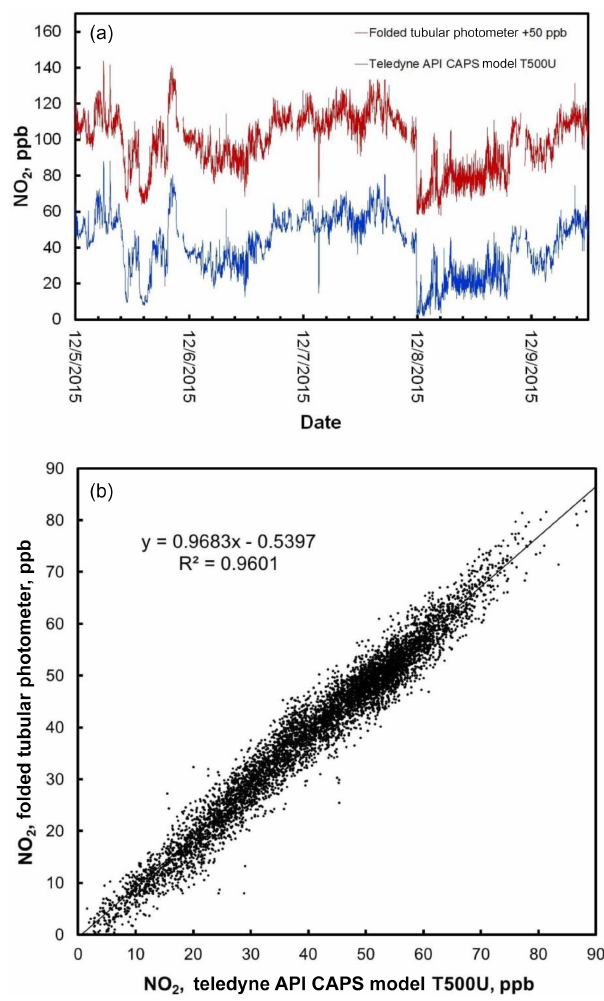
Figure 7. (a) Time series comparison plot of ambient NO 2 con- centration measured outdoors at the Colorado Department of Public Health and Environment (CDPHE) Interstate 25/Globeville road- side site using a Teledyne API model T500U (lower data line in blue) and a folded tubular photometer (upper data line in red). Data for the folded tubular photometer are offset for clarity by adding 50ppb to the measurements. (b) The same data, shown as a corre- lation plot.